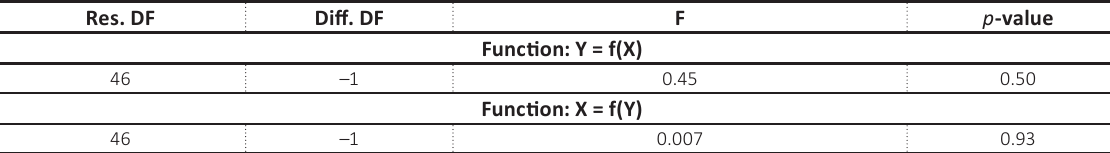
Table E8. SDGI score 2016 (X) and non-government corporate ESG disclosure (Y) Res. DF